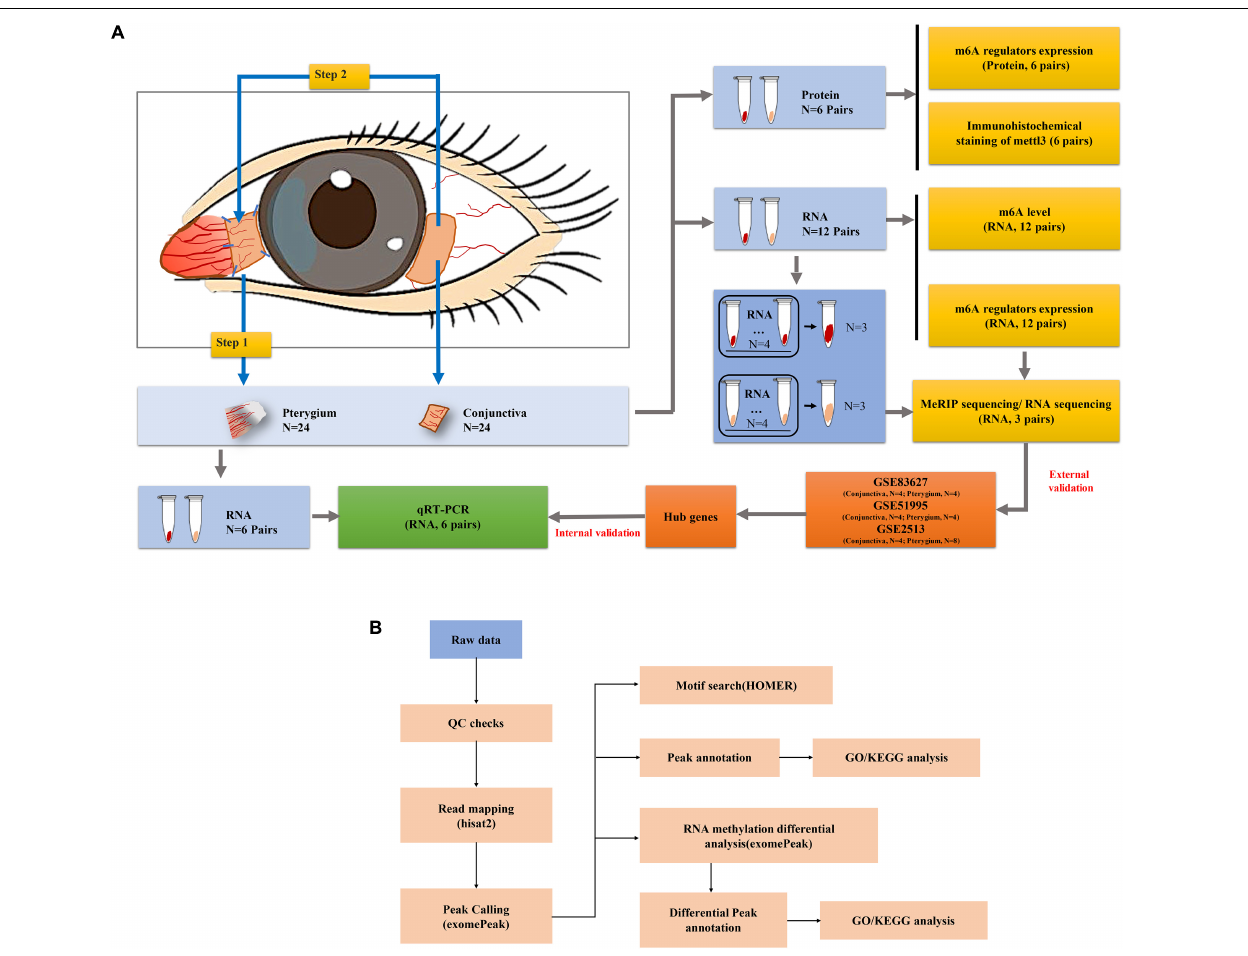
FIGURE 1 | Workflow of the study. (A) Workflow of the experimental process. (B) Workflow of the data